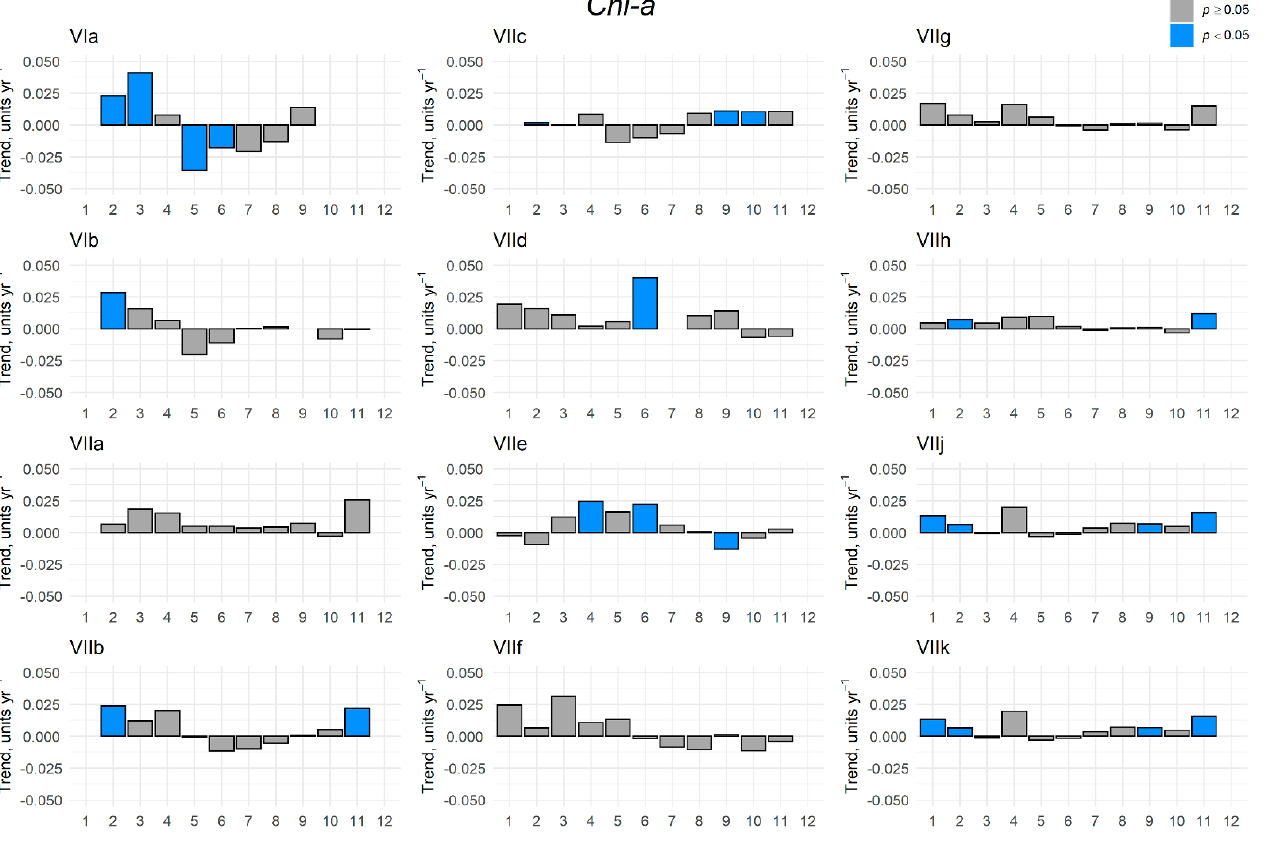
Figure 6. Monthly trends for the different ICES divisions. Bar heights measure trend magnitude for each month (Sen’ slope) over the period 1998-2016. Blue bars are significant trends ( p < 0.05) based on the Mann-Kendall test. The bar is omitted if the proportion of missing values in the first and last fifths of the data is less than 0.5.